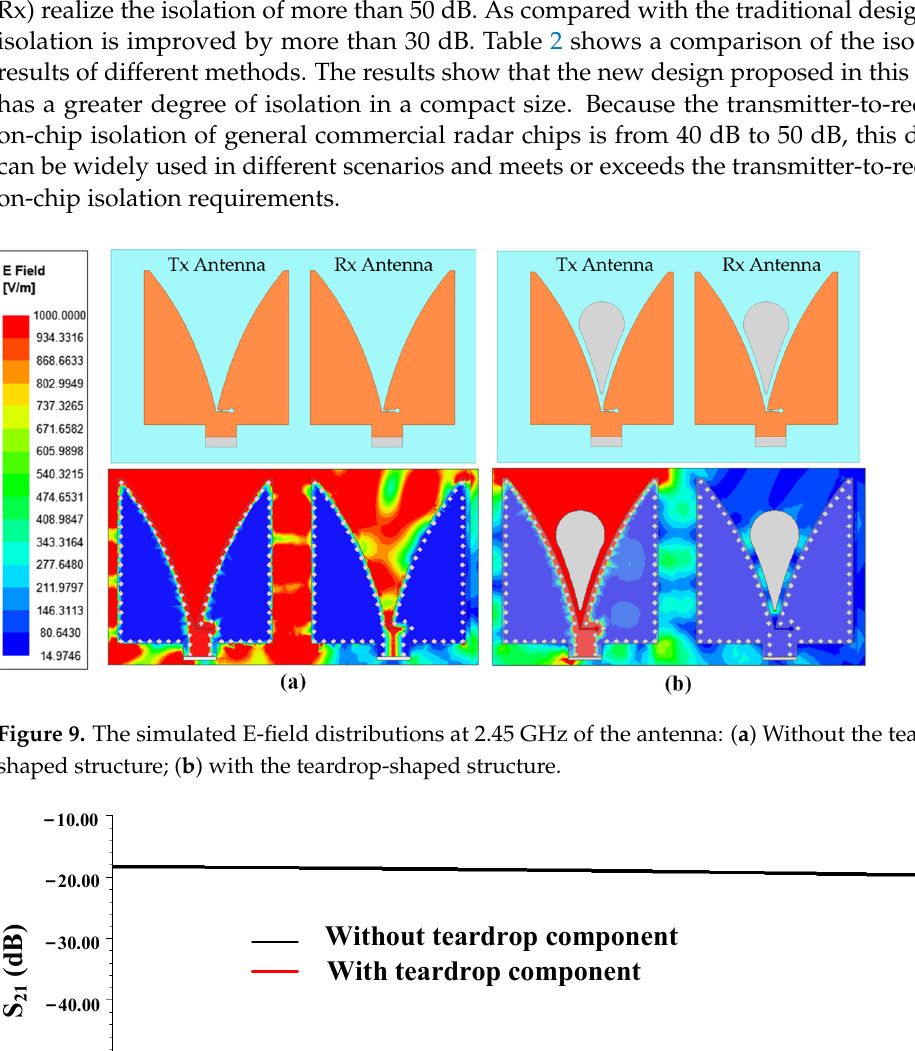
Figure 9. The simulated E-field distributions at 2.45 GHz of the antenna: ( a ) Without the teardrop- shaped structure; ( b ) with the teardrop-shaped structure.